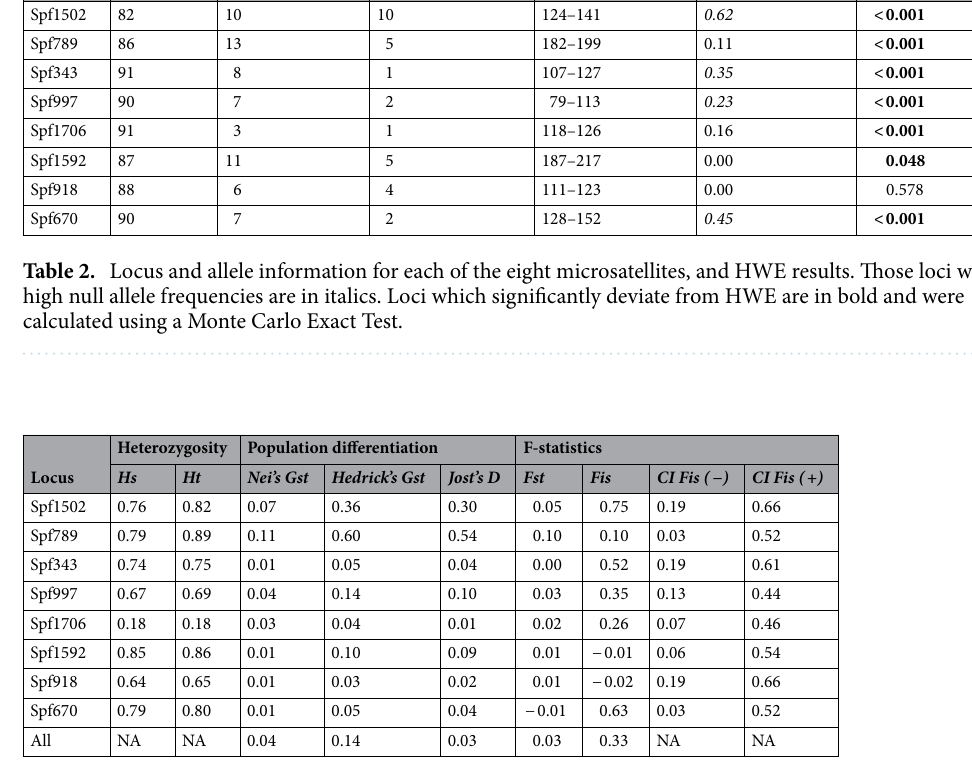
Table 3. Genetic differentiation measures for FAW in Africa based on the eight microsatellites. In all three measures tested, a value of 0 suggests very little genetic differentiation (panmixia) and 1 suggests high levels of segregation. All measures are based on Hs (heterozygosity within populations) and Ht (heterozygosity without population structure). F-statistics represent genetic variance in a subpopulation compared to the whole ( Fst — values closer to 1 suggest high levels of differentiation between populations) or in a subpopulation compared to individuals within that subpopulation ( Fis —values close to 1 suggest high levels of inbreeding in populations). Negative values of Fst and Fis should be interpreted as 0 and suggest very low differentiation of populations ( Fst ) or very low chance of inbreeding ( Fis ). Confidence intervals of Fis based on bootstrapping are also